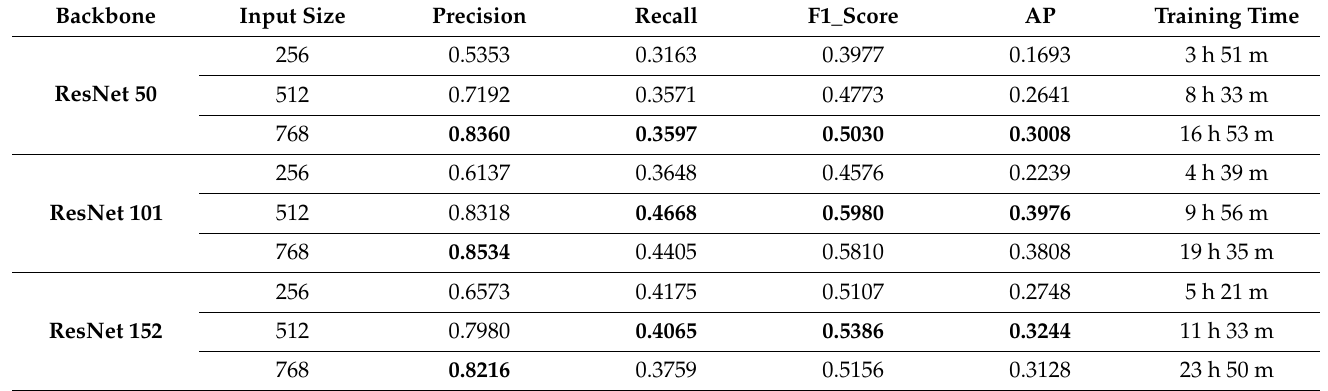
Table 2. Comparing the performance of Mask RCNN with ResNet models and input sizes. Here, epochs = 30, batch size = 2, and 10% of the 4402 training samples were used for validation.